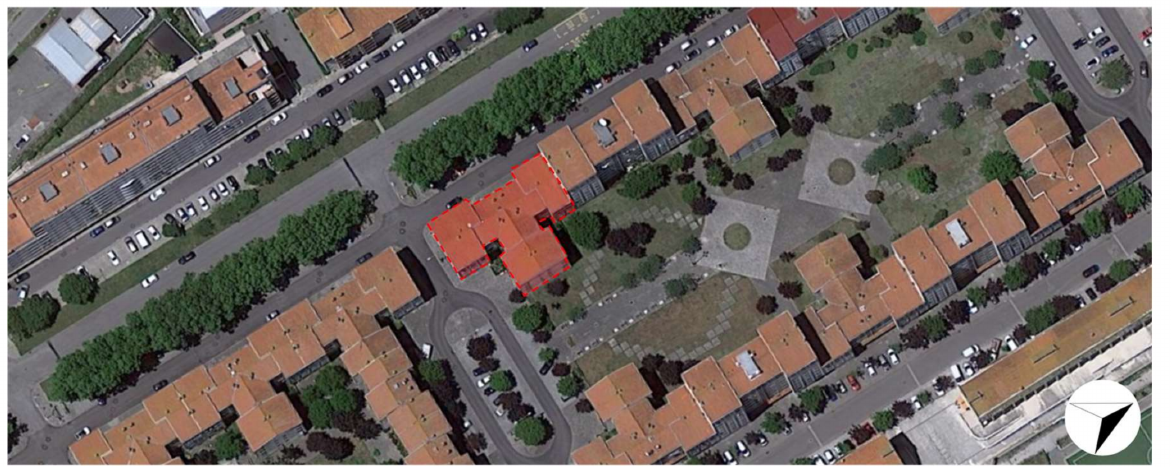
Figure 1. General view the social housing neighbourhood with the case study building highlighted in